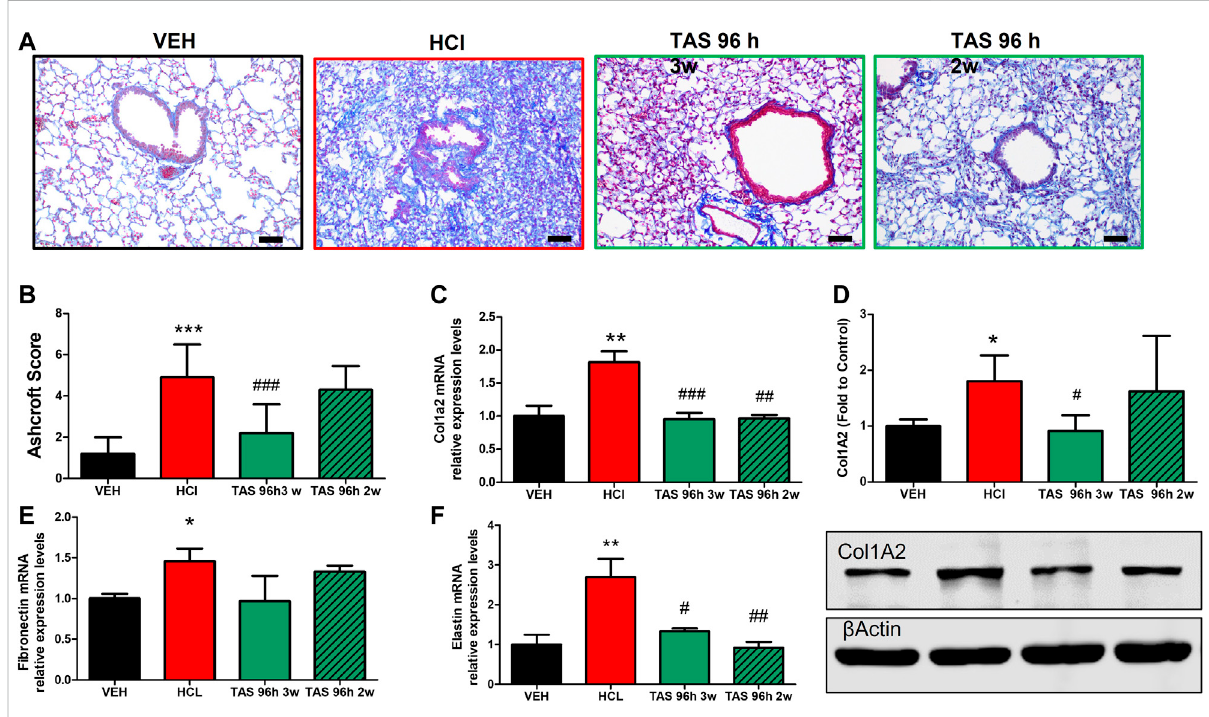
3 weeks treatment with TAS-116 ameliorates HCl-induced pulmonary fi brosis. Mice received intratracheal 0.1N HCl or saline followed by treatment, starting 96 h later, with TAS-116 (7 mg/kg 5×/week p. o.) for 2 or 3 weeks. Masson ’ s Trichrome staining of lung sections demonstrates accumulation interstitial,peribronchial andperivascularcollageninHCl-instilledmice.AnimalstreatedwithTAS-116for3 weeksexhibitedimproved lung architecture (A) and lower Ashcroft score (B) . The level of collagen type I was indicated via qPCR (C) and Western Blotting (D) . mRNA expression ofextracellular matrix Fibronectin (E) and Elastin (F) were measured via qPCR. Original magni fi cation ×20; blackscalebarscorrespondto 50 µm (Means ± SEM; n = 4 – 6; ***: p < 0.001; **: p < 0.01, *: p < 0.05 from VEH; # : p < 0.05, ## : p < 0.01, ### : p < 0.001 from HCl, with one-way ANOVA and Tukey ’ s post-hoc